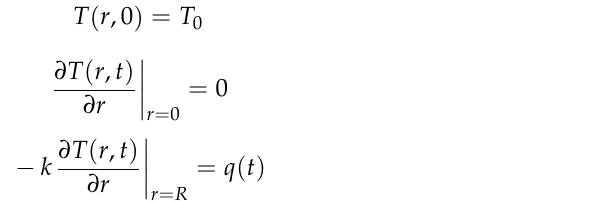
Figure 4. Schematic diagram of one-dimensional heat transfer.